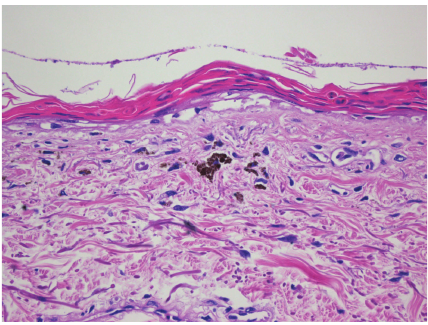
Figure 2: Toxic epidermal necrolysis-like lesion with full thickness necrosis of the epidermis and pigment incontinence (H&E ×